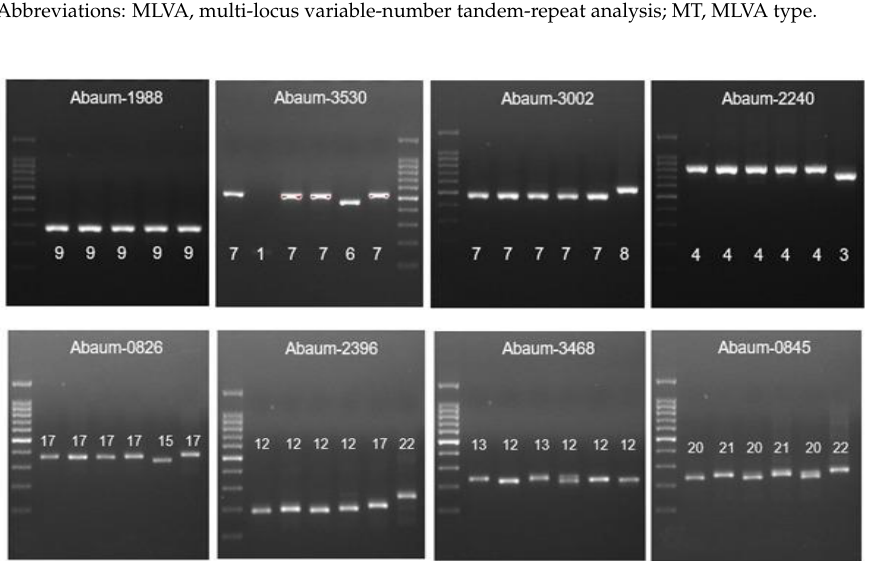
Figure 3. The MLVA typing of CRAb-cc isolates from Prof. Dr. R. D. Kandou Hospital, Manado. Lane 1 = DNA ladder; lane 2 = MDO-25; lane 3 = MDO-9; lane 4 = MDO-27; lane 5 = MDO-2; lane 6 = MDO-29; lane 7 = MDO-30*. * Abaum-1988: captured in another gel. Abaum-3530: the sample order is the same, but the DNA ladder is in lane